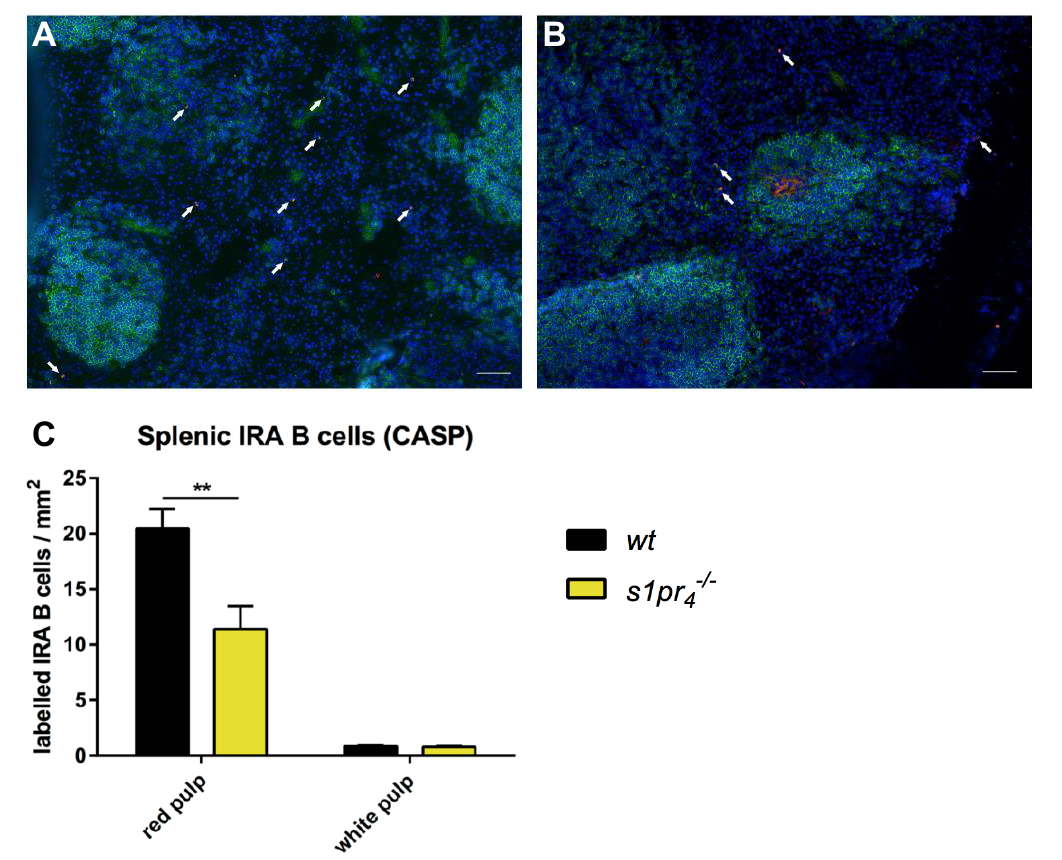
Figure 8. Quantification of IRA B cells in the spleen after CASP. Seven days after sepsis induction by colon ascendens stent peritonitis (CASP), the number and localization of splenic IRA B cells in wt ( A ) and s1pr 4−/− ( B ) mice were analyzed. Splenic tissue sections were stained with anti-B220 (green), anti-GM-CSF (red), and DAPI (blue). IRA B cells were identified as B220 + GM-CSF + cells and are marked with white arrows (white bars equal 50 µm). ( C ) The number of IRA B cells was compared between wt and s1pr 4−/− animals for both splenic compartments. Bars depict the mean values (+SEM) of IRA B cell counts ( n = 6) (white scale bar equals 50 µm). ** p < 0.01.